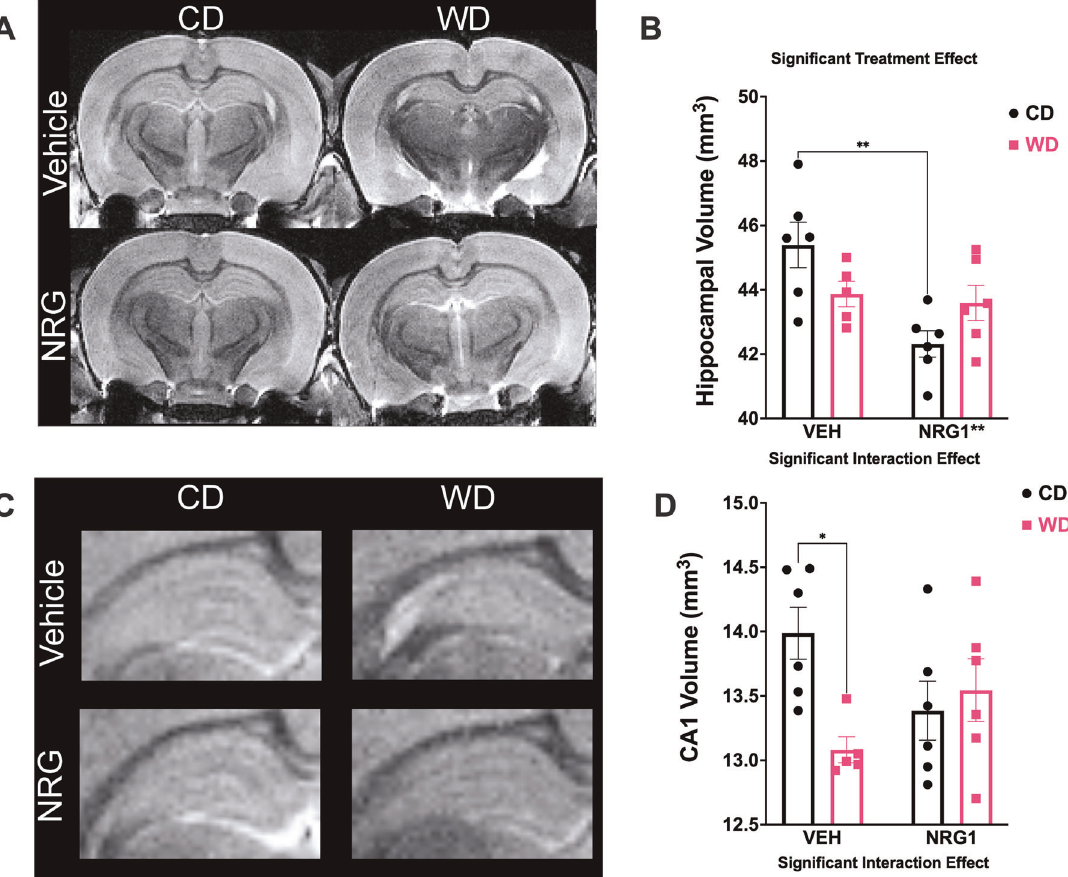
Fig. 3 Obesogenic diet and prolonged NRG1 administration interact to in fl uence hippocampal volumes. A , B Total hippocampal volume (both left and right hippocampi combined) were affected by the treatment [ F (1, 19) = 9.48, p = 0.006]. Subchronic NRG1 administration during adolescence resulted in signi fi cant total hippocampal volume reduction (CDV vs. CDN, p = .003). C , D Hippocampal sub fi eld segmentation showed a signi fi cant interaction [ F (1, 19) = 6.44, p = 0.020] effects on CA1 region. WDV rats had a signi fi cantly smaller CA1 volume than CDV rats ( p = 0.015). Sample size = 6